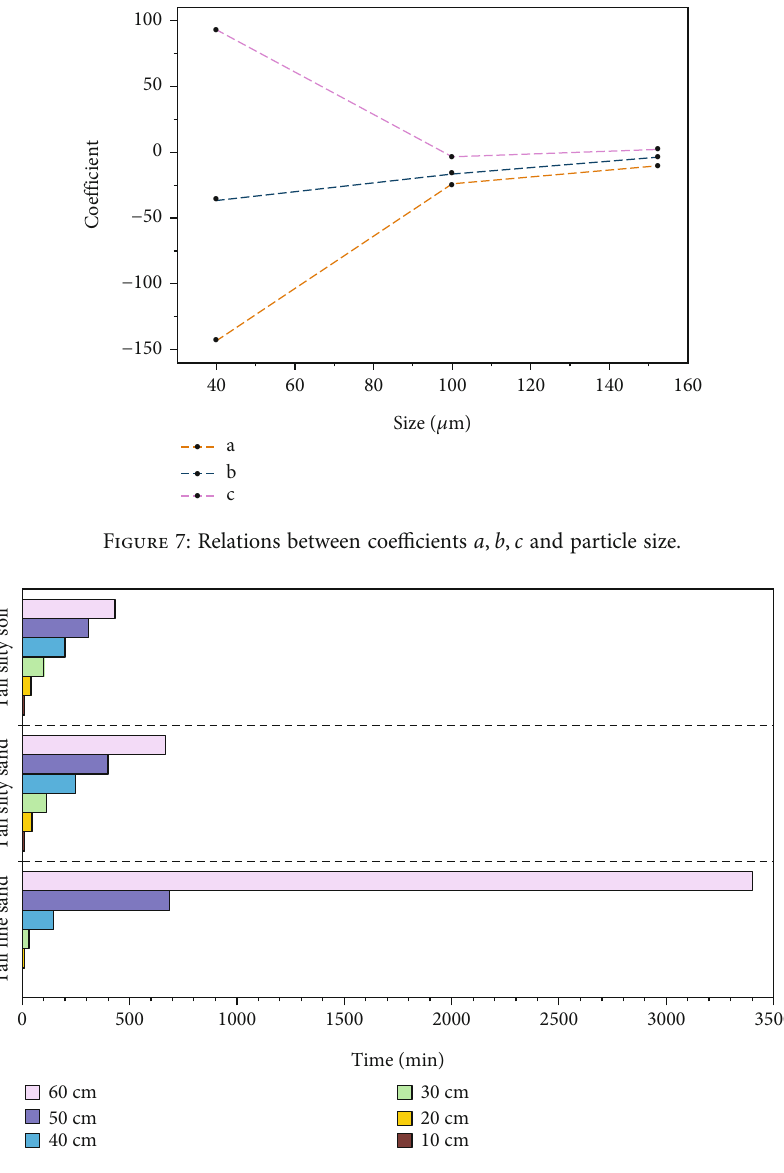
Figure 8: Comparison of capillary water